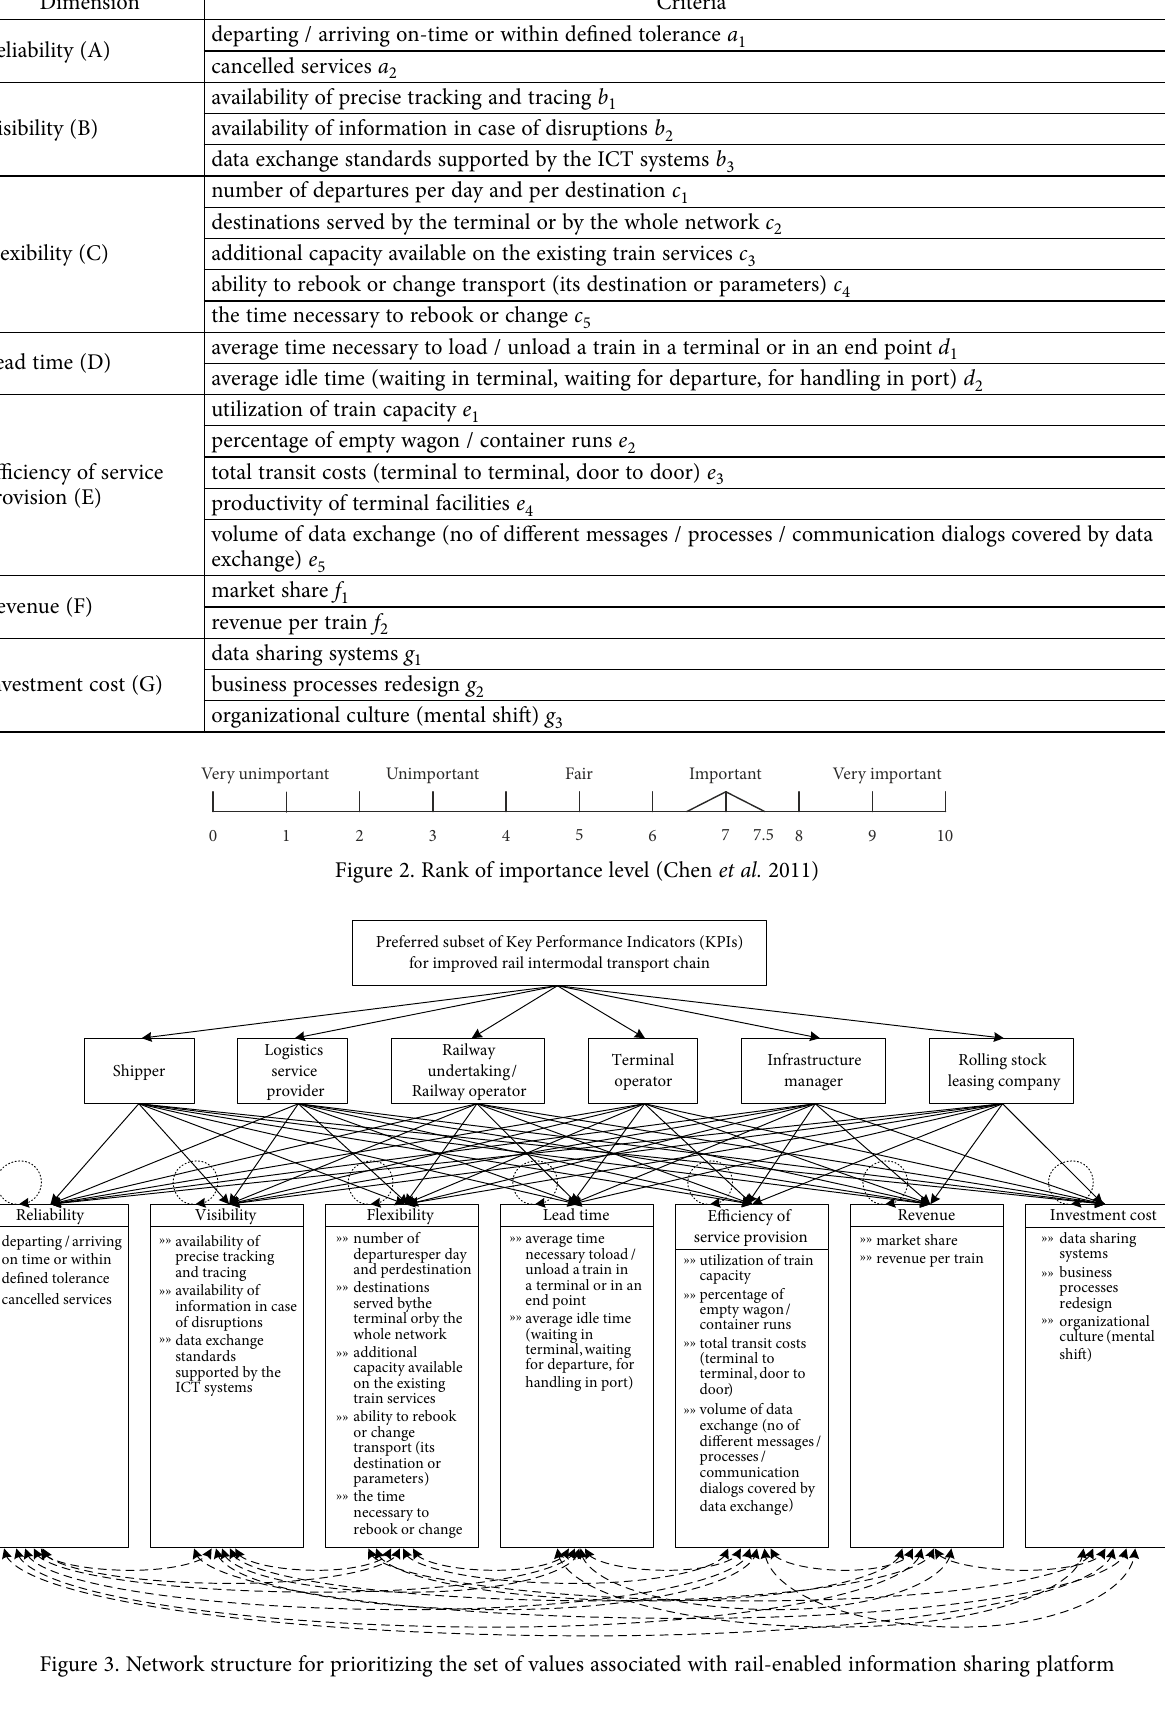
Table 4. Attributes with a mean of 7.5 and above